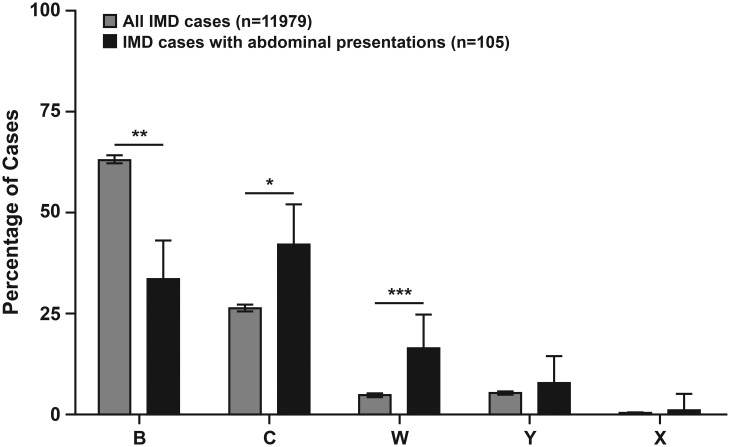
Serotypes responsible for all IMD cases or cases with abdominal presentation in France, 1991–2016. Percentages are provided along with the 95% CIs (*P < 0.01, **P < 0.001, ***P < 0.0001). Adapted with permission from Guiddir et al., Clinical Infectious Diseases 2018; 67: 1220-1227 [3].